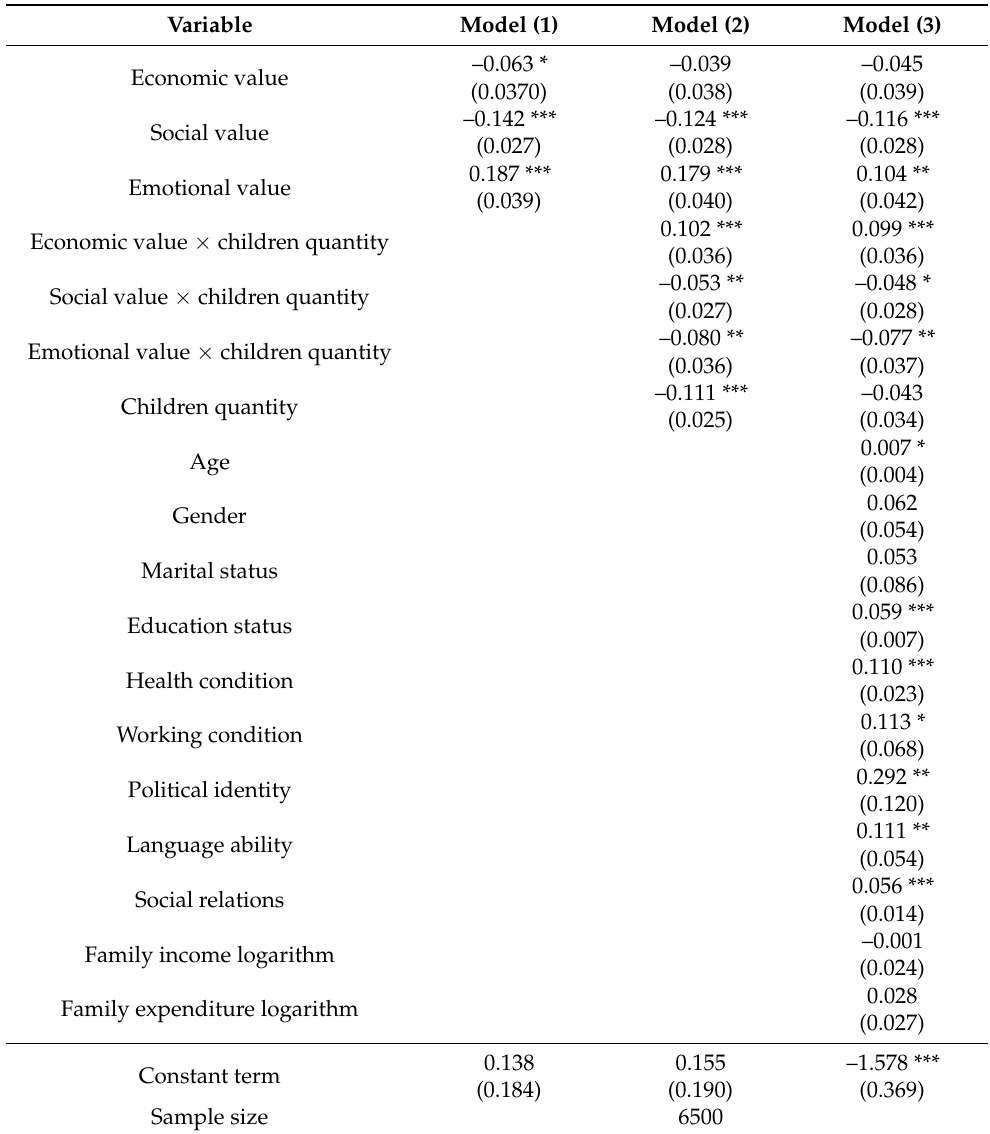
Table 3. Regression results of farmers’ children’s value influencing the social trust moderating effect